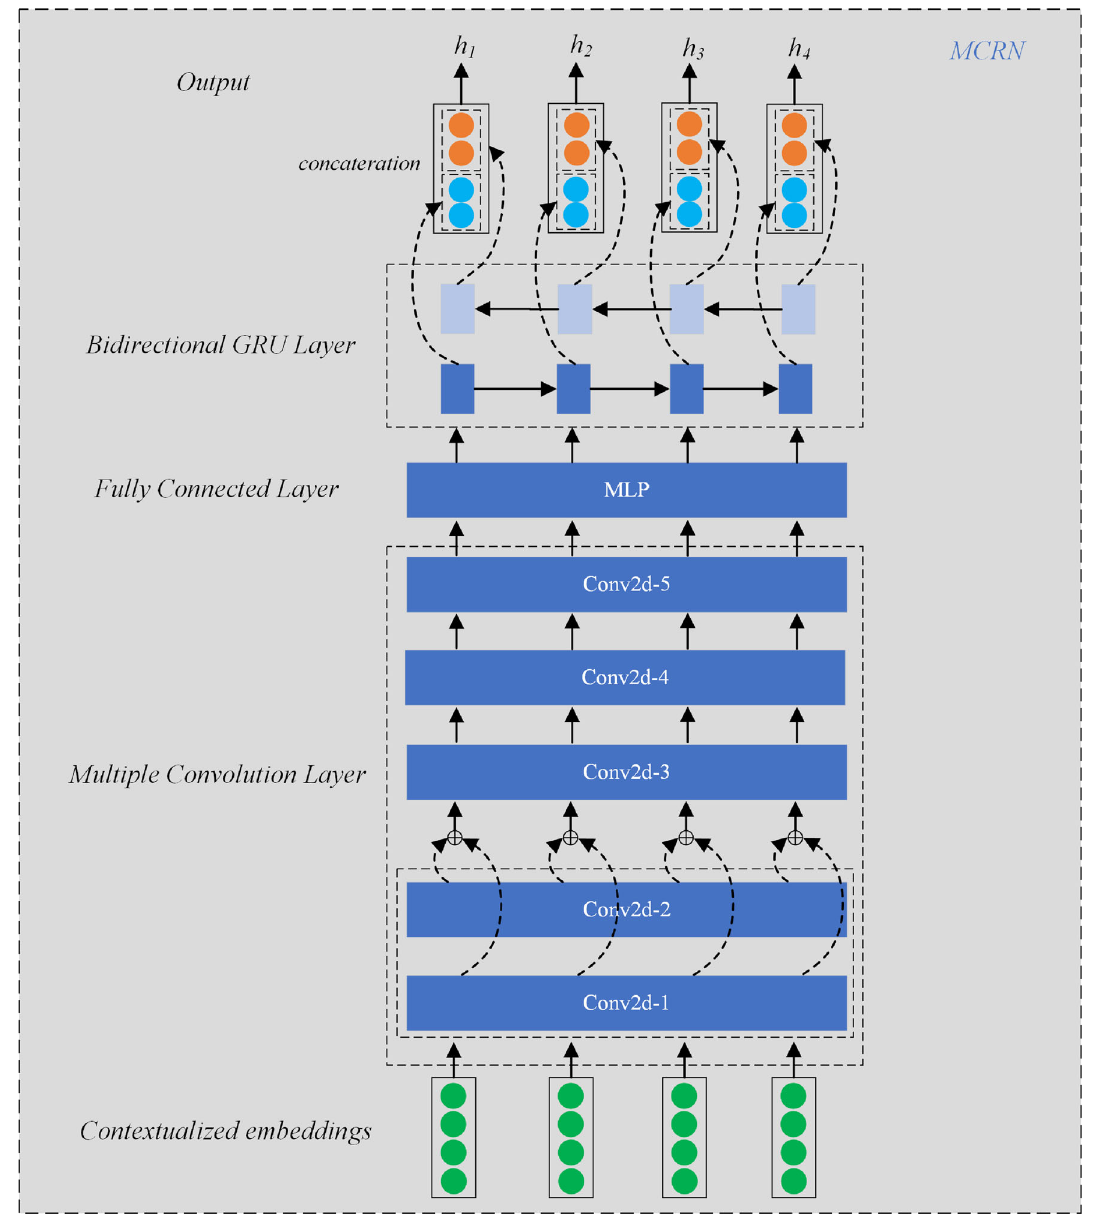
Fig. 3 The overall architecture of MCRN